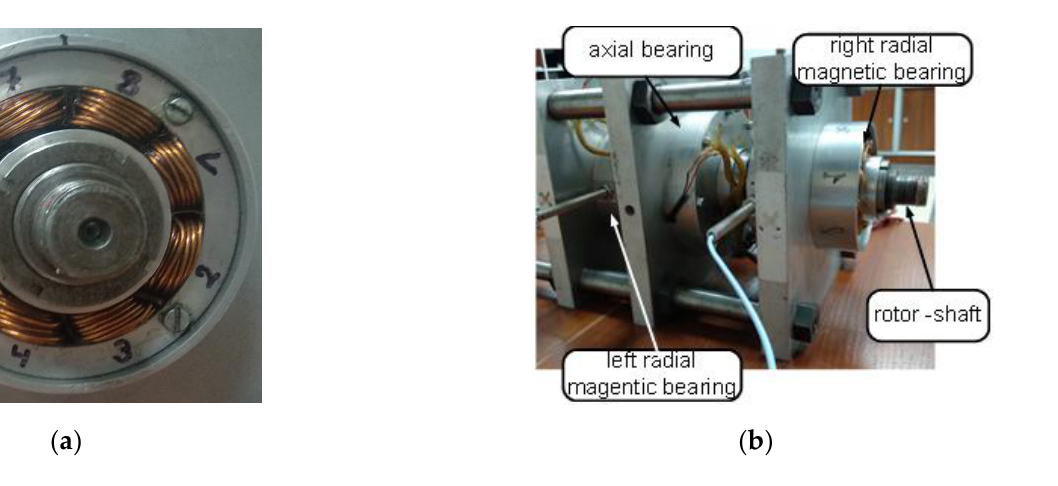
Figure 17. Laboratory object: ( a ) radial active magnetic bearing; ( b ) rotor – shaft support system. During experimental verification of the generated magnetic forces, time histories of the vertical rotor – shaft raceway displacements in the air gap and the control current were registered for different reference signal values. These courses had the form of a square wave with an amplitude of 0.001, 0.002, 0.005, 0.007, 0.01 V and a frequency of 1 Hz. The registered exemplary time histories are presented in Figure 18.